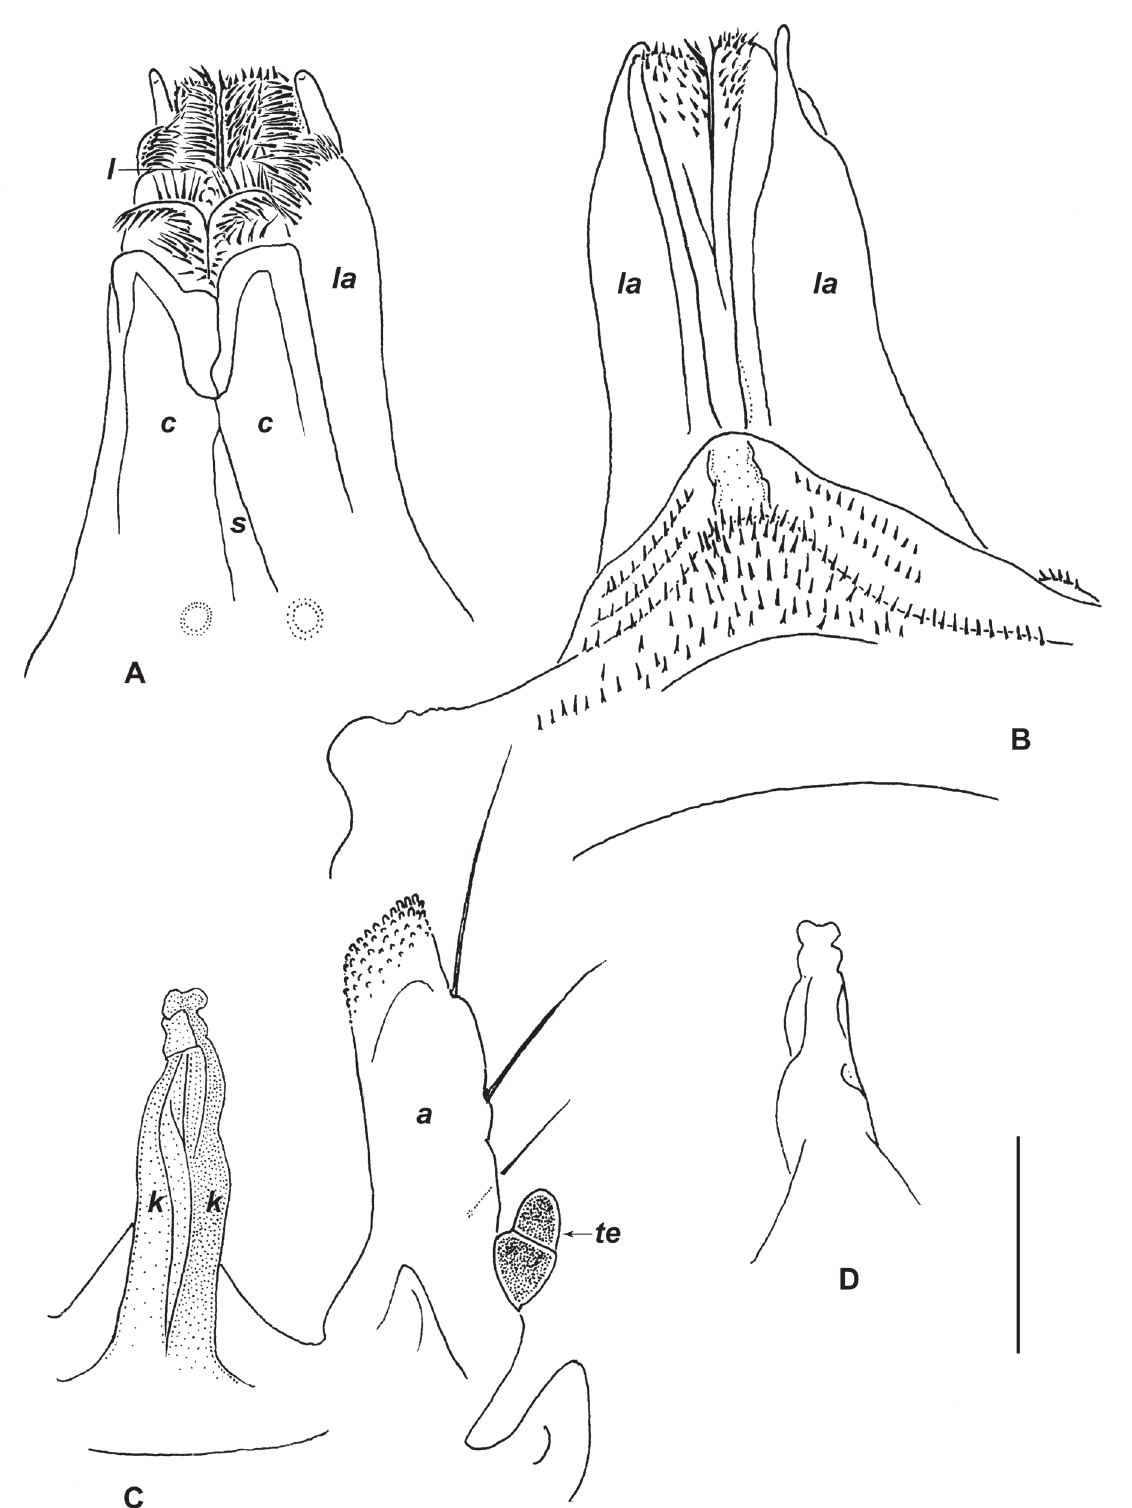
Fig. 6. Gonopods of Anamastigona strasseri sp. nov., ♂, holotype. A . Anterior gonopods, caudal, slightly lateral view. B . Anterior gonopods, frontal, slightly lateral view. C . Posterior gonopods, frontal view. D . Right colpoxite of posterior gonopods, caudal view. Abbreviations as in Fig. 3. Scale bar = 0.1